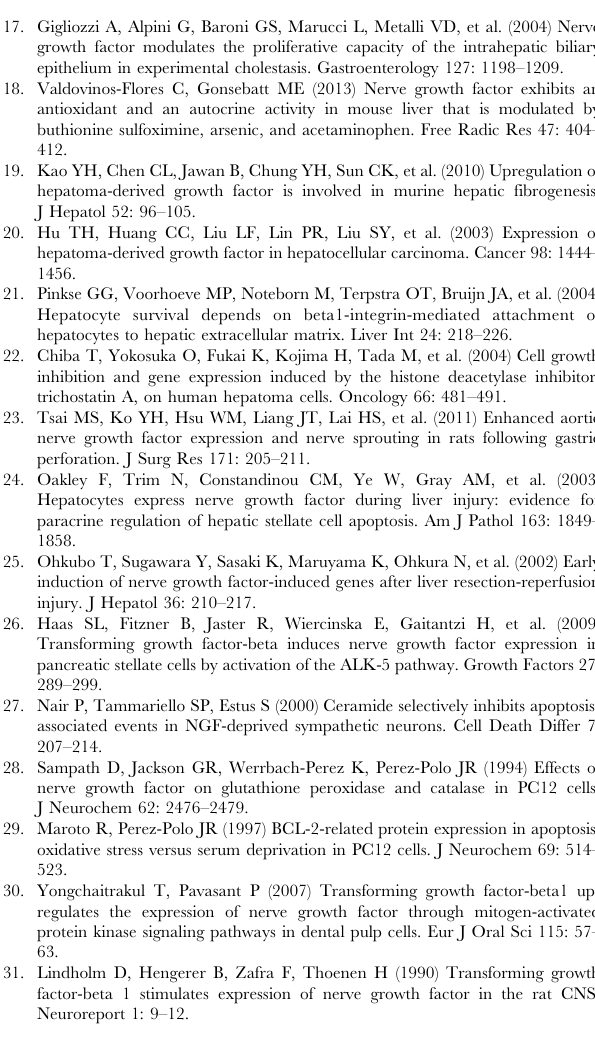
Figure S6 Immunohistochemistry showing parenchy- mal localization of TrkA and p75NTR peptides in normal mouse livers. Formalin-fixed and paraffin-embedded mouse liver tissues were subjected to immunohistochemical staining and counterstaining with hematoxylin. Note that homogenous pattern and sparsely spotted distribution of TrkA and p75 NTR, two NGF cognate receptors, were seen in parenchyma of normal mouse livers. Images at right panel are the magnified rectangular area indicated by dashed lines in left images. Bars = 100 m